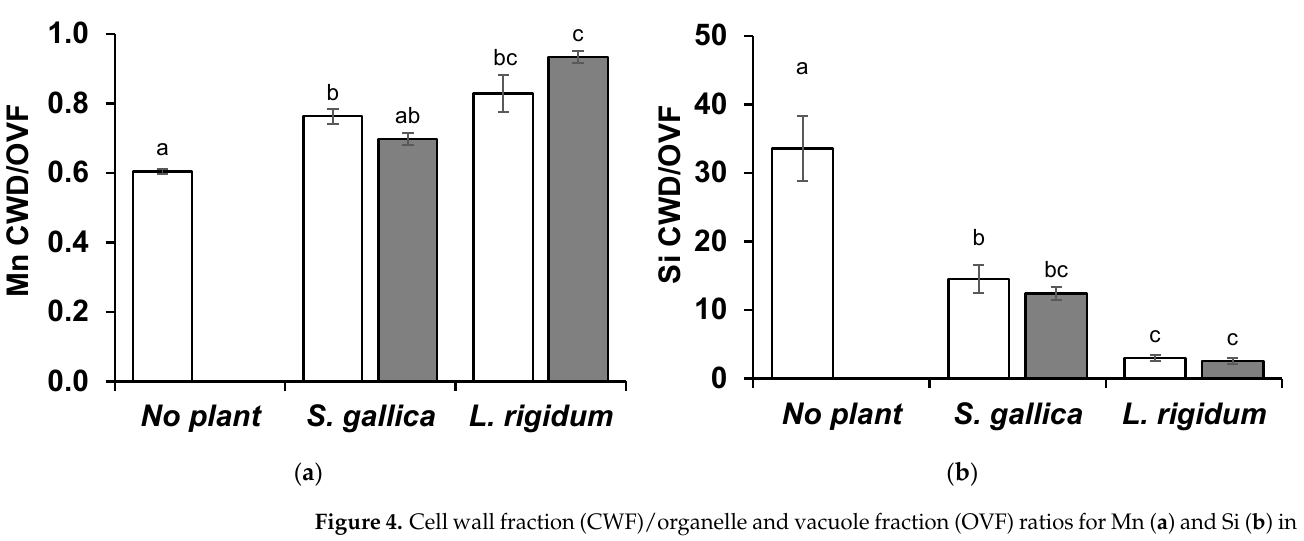
Figure 4. Cell wall fraction (CWF)/organelle and vacuole fraction (OVF) ratios for Mn ( a ) and Si ( b ) in shoots of 3-week-old wheat grown in disturbed (white columns) and undisturbed (grey columns) acidic soil with arbuscular mycorrhizal fungi associated with previously grown Silene gallica L. (non- mycotrophic) and Lolium rigidum L. (strongly mycotrophic) and with no prior Developer (no-plants), under Mn toxic conditions. Different letters indicate statistically significant differences between the different treatments ( p < 0.05).